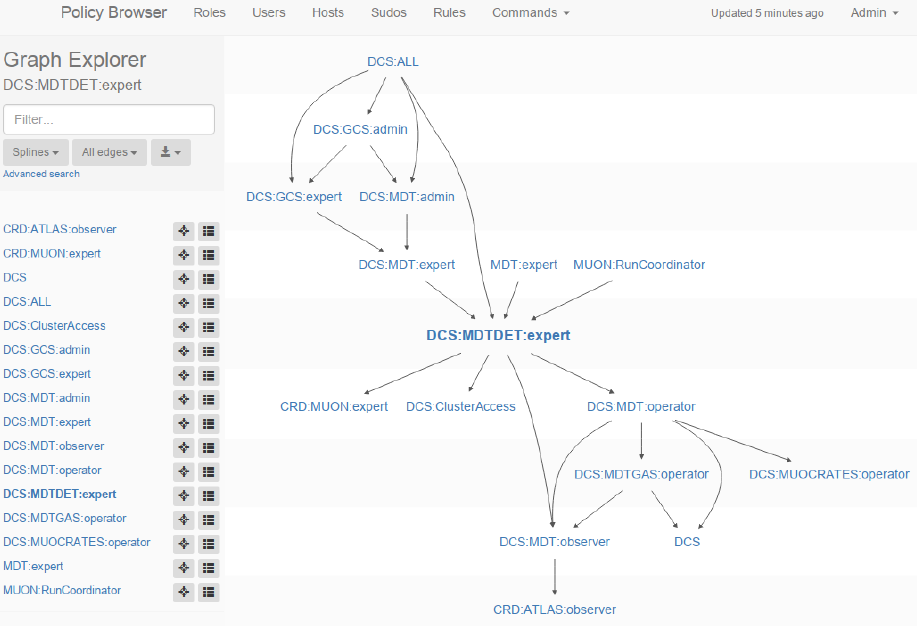
Figure 5. The graph explorer